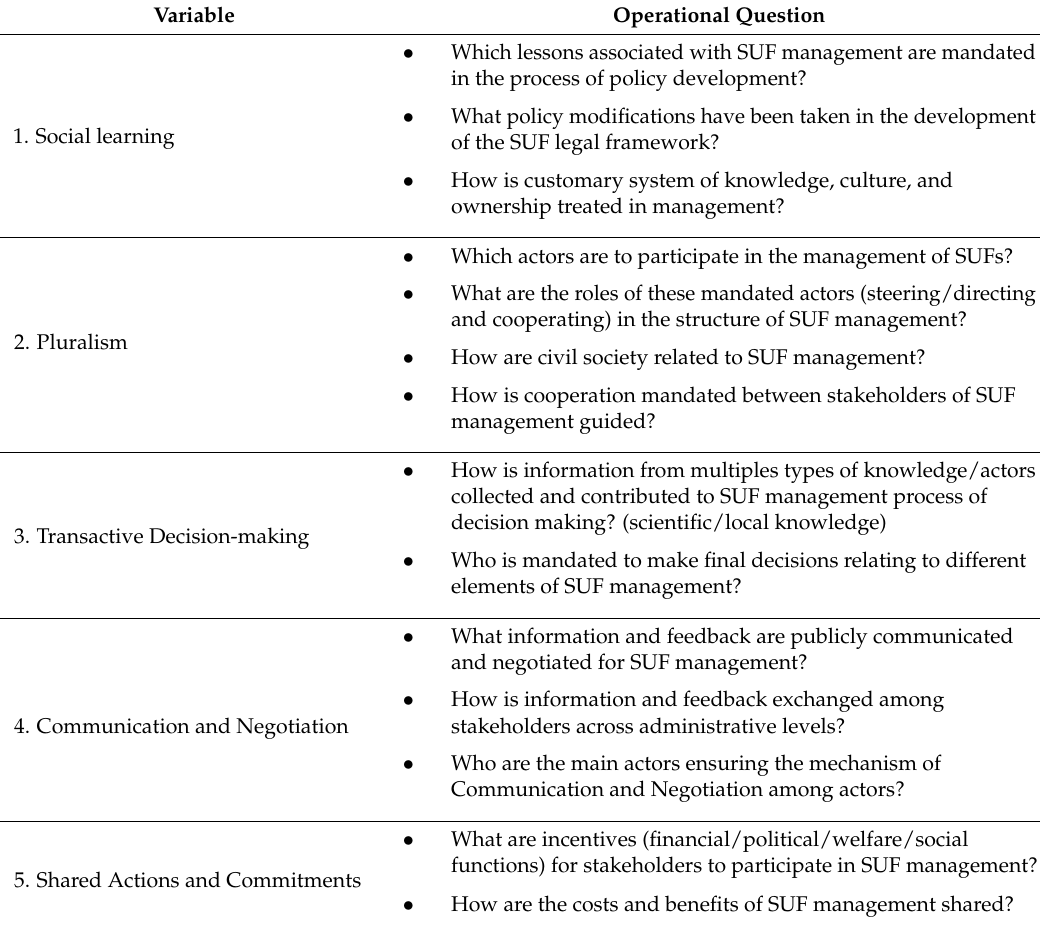
Table 1. Outline of questions asked across all document categories in systematic